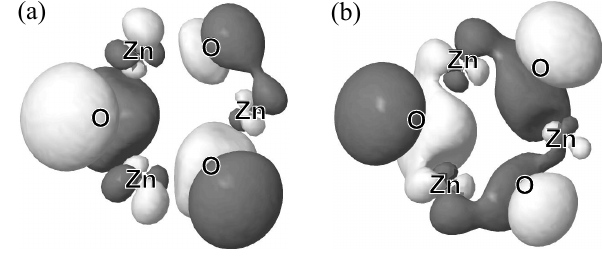
Figure 3. Molecular orbital isosurfaces for two representative lone-pair-like orbitals in a Zn O ring. Phases are indicated with light and dark shading, and 0.02 is the isovalue. 3 3 ( a ), the HOMO, is slightly Zn-O anti-bonding while ( b ), the HOMO-3, shows some Zn-O bonding, as indicated by overlap population values.